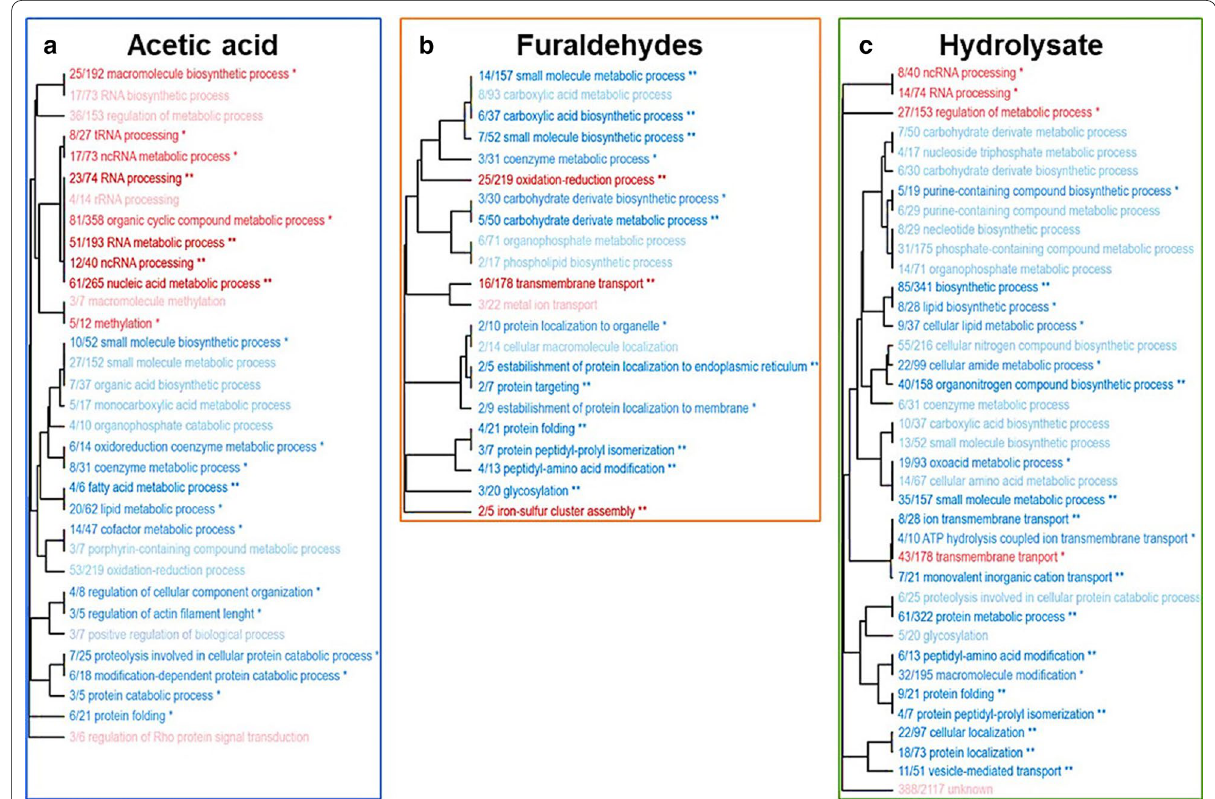
Fig. 5 Representativeness of GO categories for the DEGs of P. pastoris in presence of different inhibitors. The genes with differential expression in at least one concentration of acetic acid ( a ), furaldehydes ( b ), and hydrolysate ( c ) were used in the analysis. Up and down-regulated categories are shown in red and blue, respectively. P -values are equal to: (**) 0.01, (*) 0.05, (no symbol) 0.1. The numbers X/Y represent the number DEGs with that GO term found in the sample by the total number of genes with that GO term in the